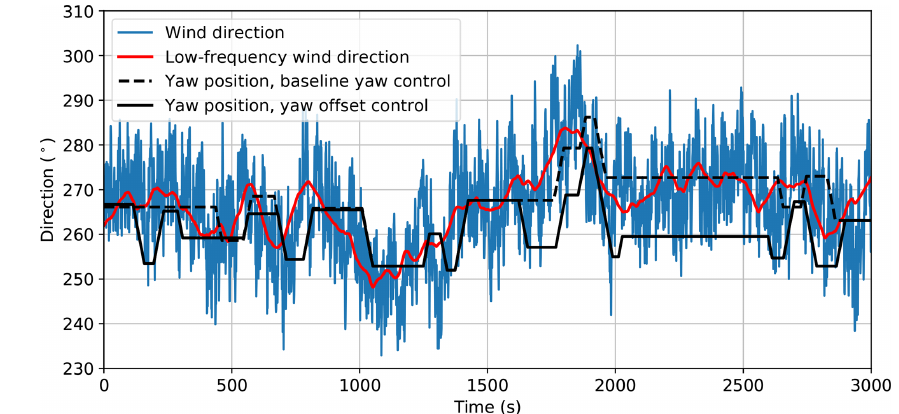
Figure 6. Example stochastic wind directions and low-frequency wind directions with yaw positions corresponding to baseline yaw control and yaw offset control, with the 8ms − 1 offset schedule shown in Fig.